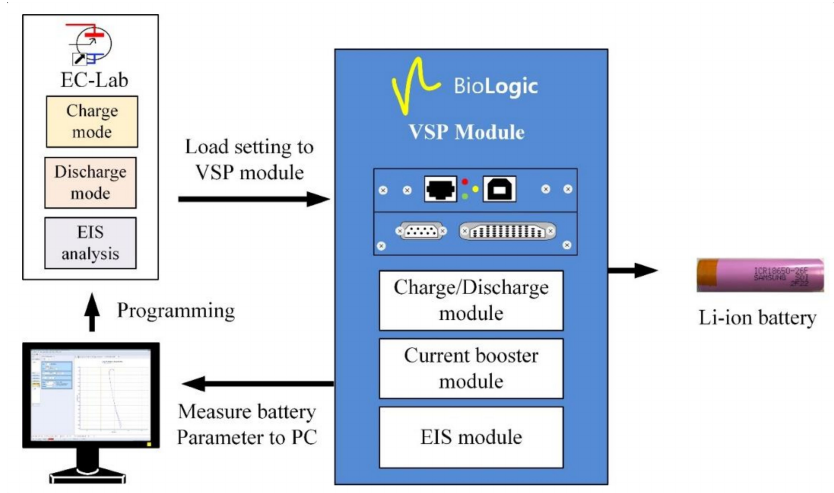
Figure 2. Block diagram of the AC Impedance analysis (ACZ) experiments.